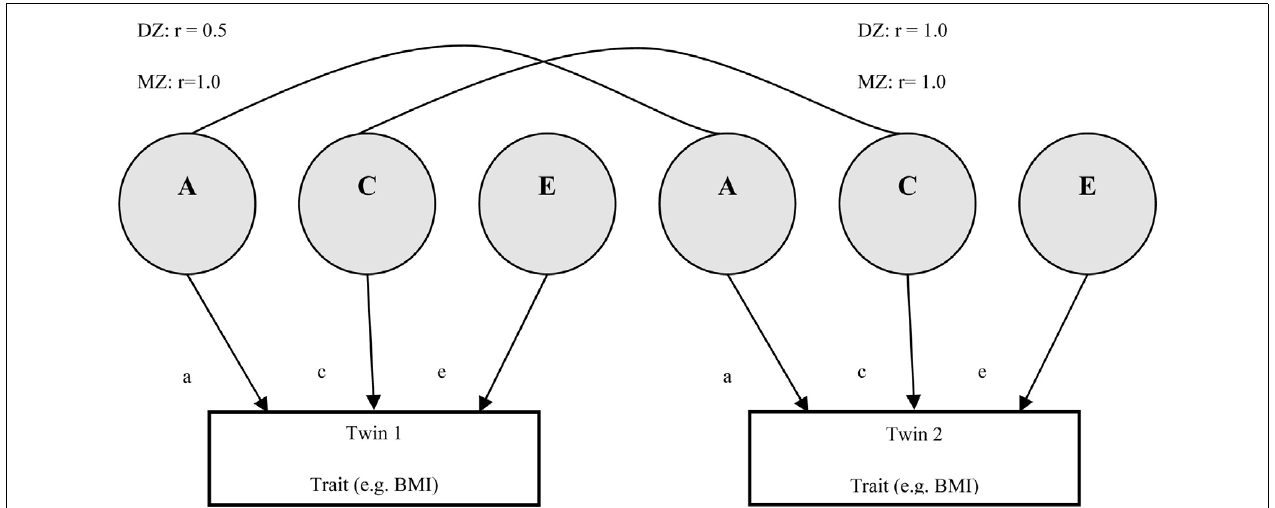
Common environment is shared (C) 100% by both types of twin. E represents a unique environmental component, and hence there is no correlation. Statistical modeling allows phenotypic variance to be quantitatively decomposed into A, C, and E subcomponents (the ACE model).The estimate of A gives a measure of the heritability of the trait. In a more parsimonious AE model, the C component would be missing from this